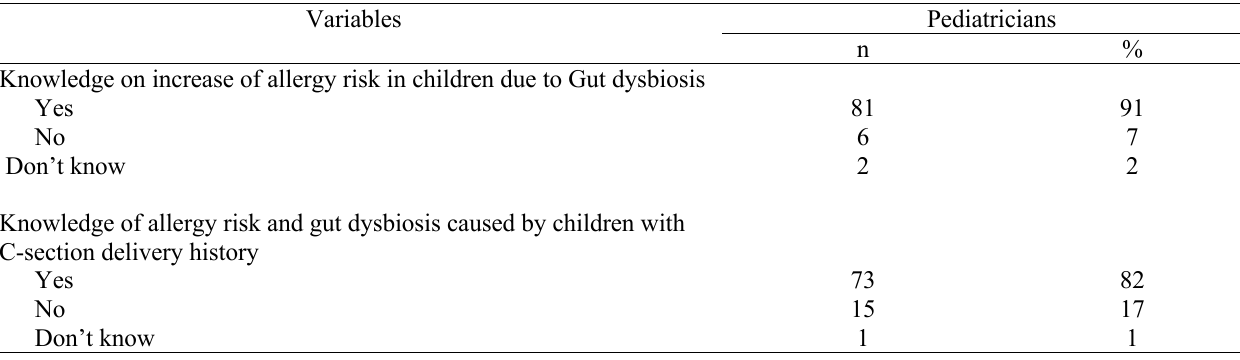
Table 2. Knowledge and attitude of children’s health risk and C-section delivery history